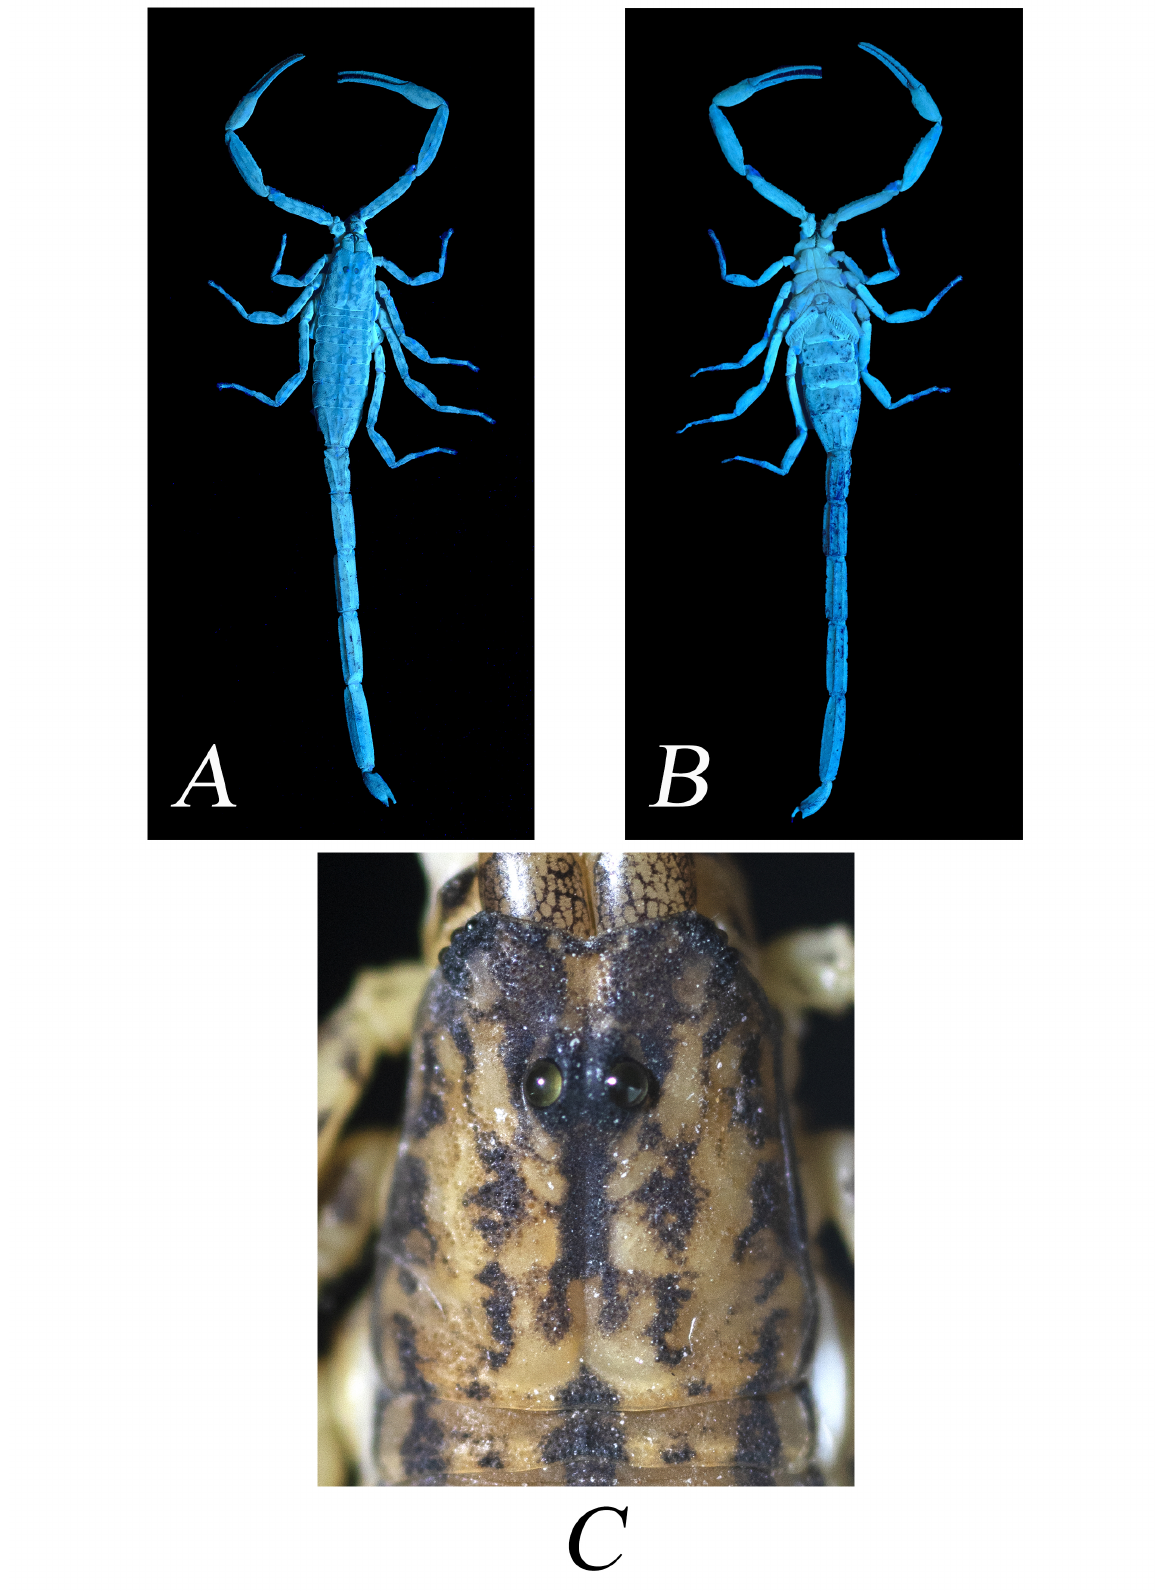
Fig. 5. Isometrus sankeriensis Tikader & Bastawade, 1983, neotype, adult ♂ (BNHS SC 194). A . Dorsal view, UV light. B . Ventral view, UV light. C . Carapace, white